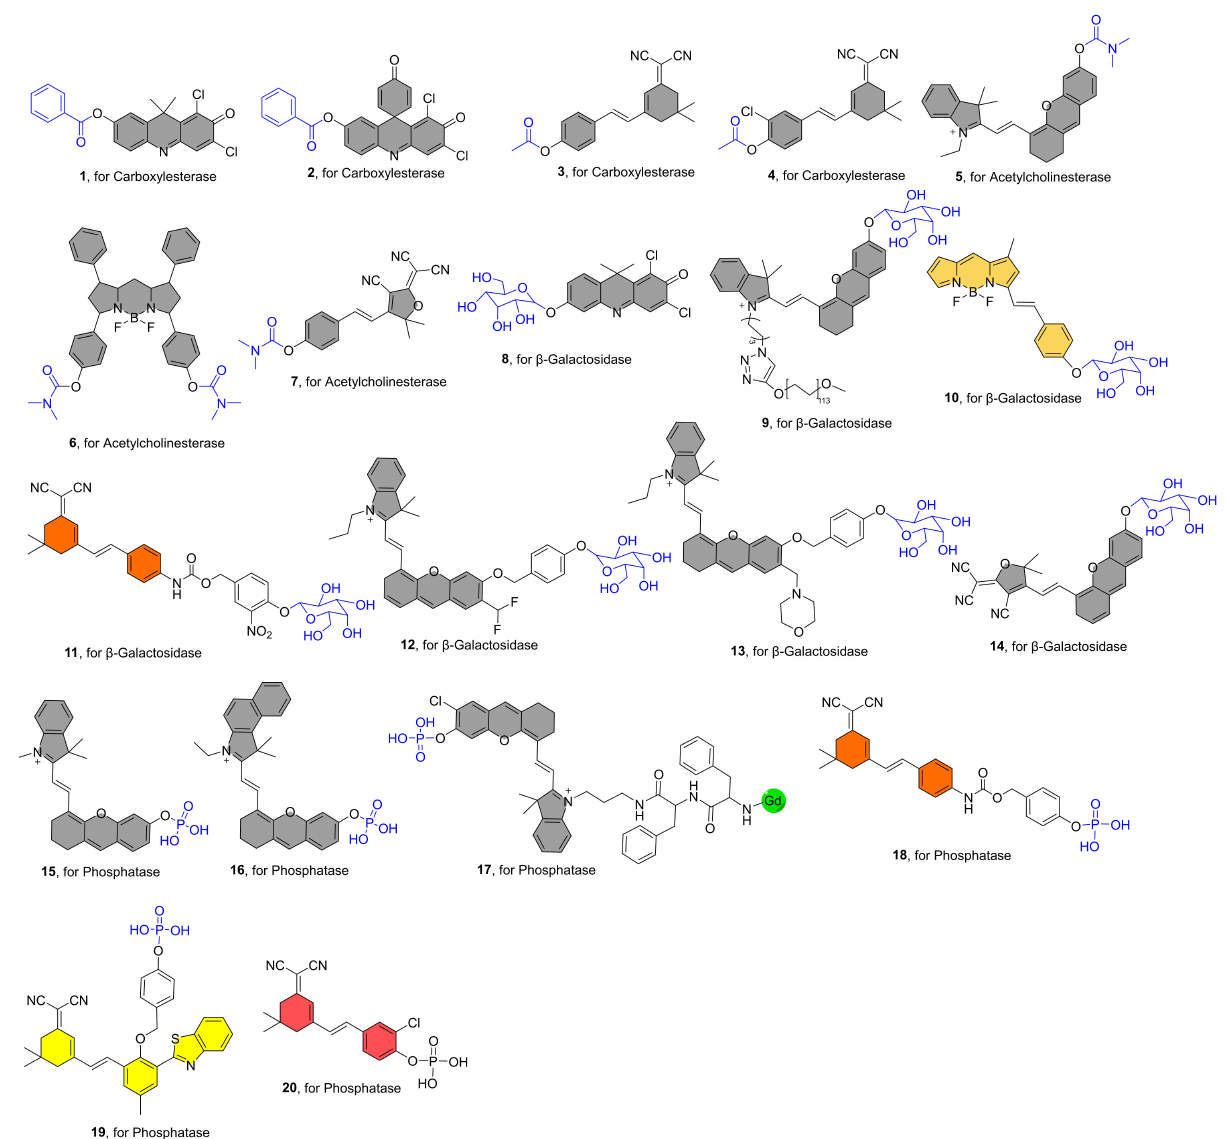
Figure 1. Structures of NIR Fluorescent Probes 1 – 20 (The gray filling of the chemical structure shows that the fluorophore molecule’s fluorescence has been quenched, while the other colors indicate that the probe molecule exhibits corresponding fluorescence signals when it does not respond to the analyte, the following Figures 2–6 are the